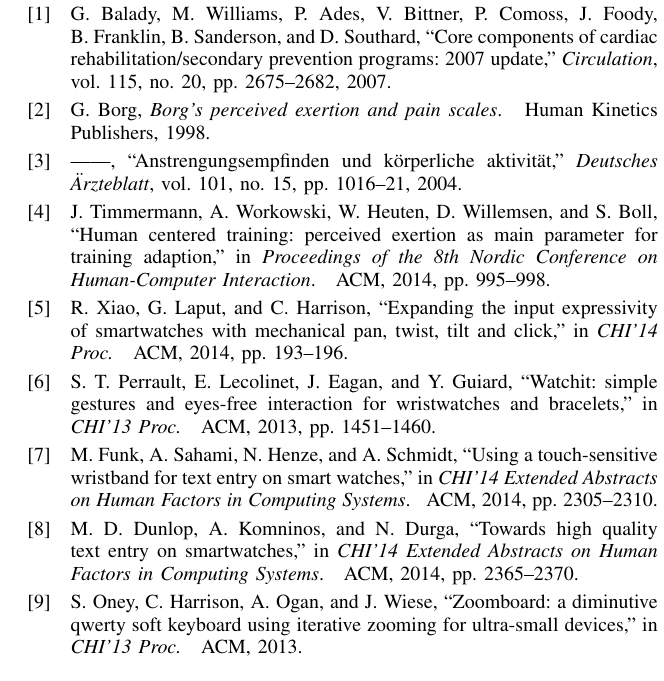
of 13 . 9% of false recognized speech per